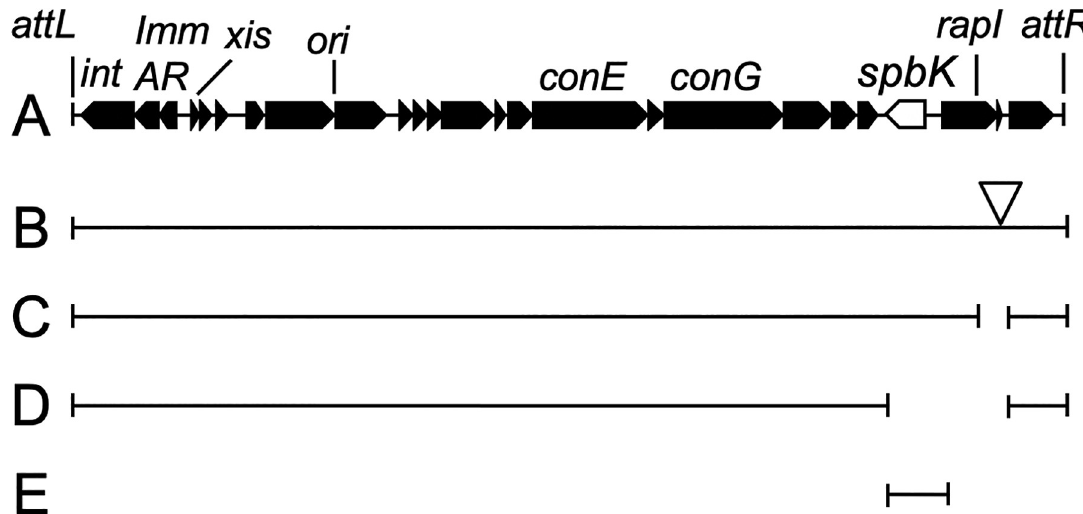
Fig 1. Map of ICE Bs1 and some mutants. A. A linear map of ICE Bs1 is shown. Genes are indicated as filled boxes with arrowheads at the ends indicating the direction of transcription. spbK is shown as an open arrow. The attachment sites attL and attR mark the junctions between ICE Bs1 and chromosomal sequences. Below the map are shown the ICE Bs1 mutants used in this work. The regions of ICE Bs1 that are present in each construct are shown as bars beneath the map. B. ICE Bs1 :: kan . The open triangle indicates that this construct contains a kan gene inserted in the intergenic region between rapI and yddM . C. ICE Bs1 Δ ( rapI-phrI ). D. ICE Bs1 Δ (